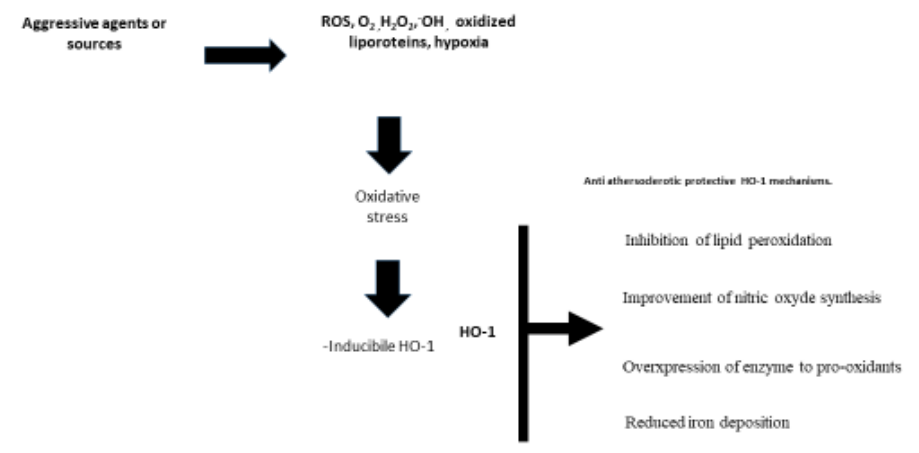
Figure 2. Figure shows the source and agents able to induce the oxidative stress. The picture briefly summarizes the capabilities of HO 1 in protecting against the atherosclerotic process. ROS = reactive oxidized species, O 2 di-oxygen (singlet), H 2 O 2 = peroxide, OH = hydroxide ion, HO-1 = heme oxygenase 1.